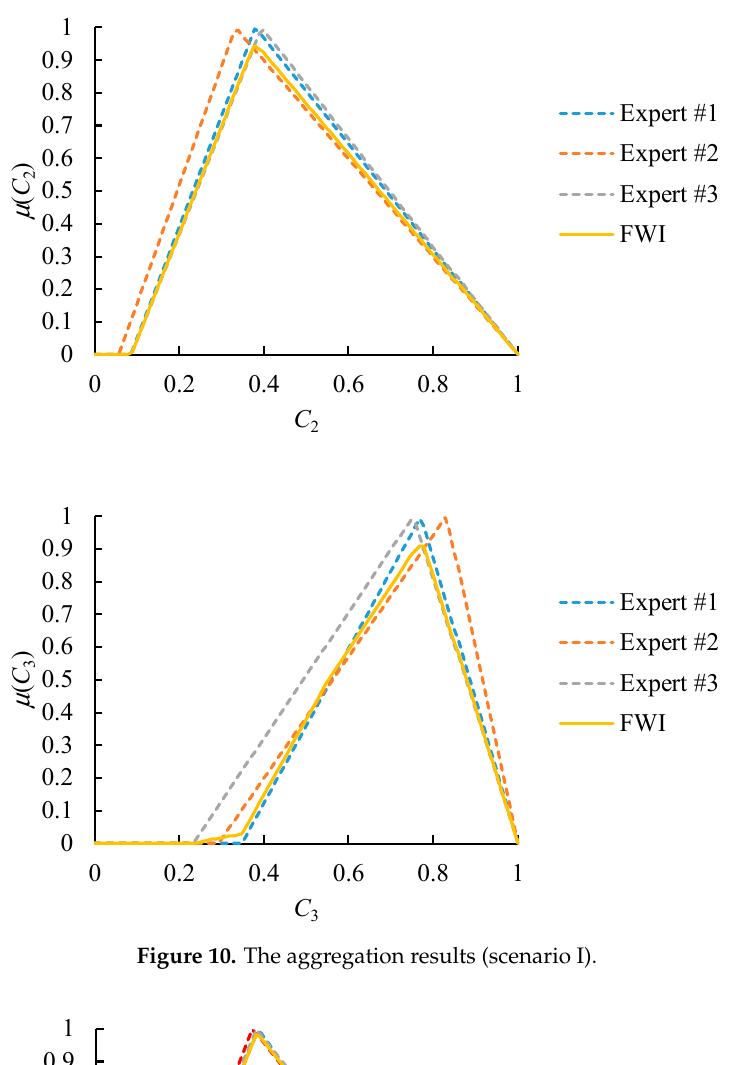
Figure 10. The aggregation results (scenario I).